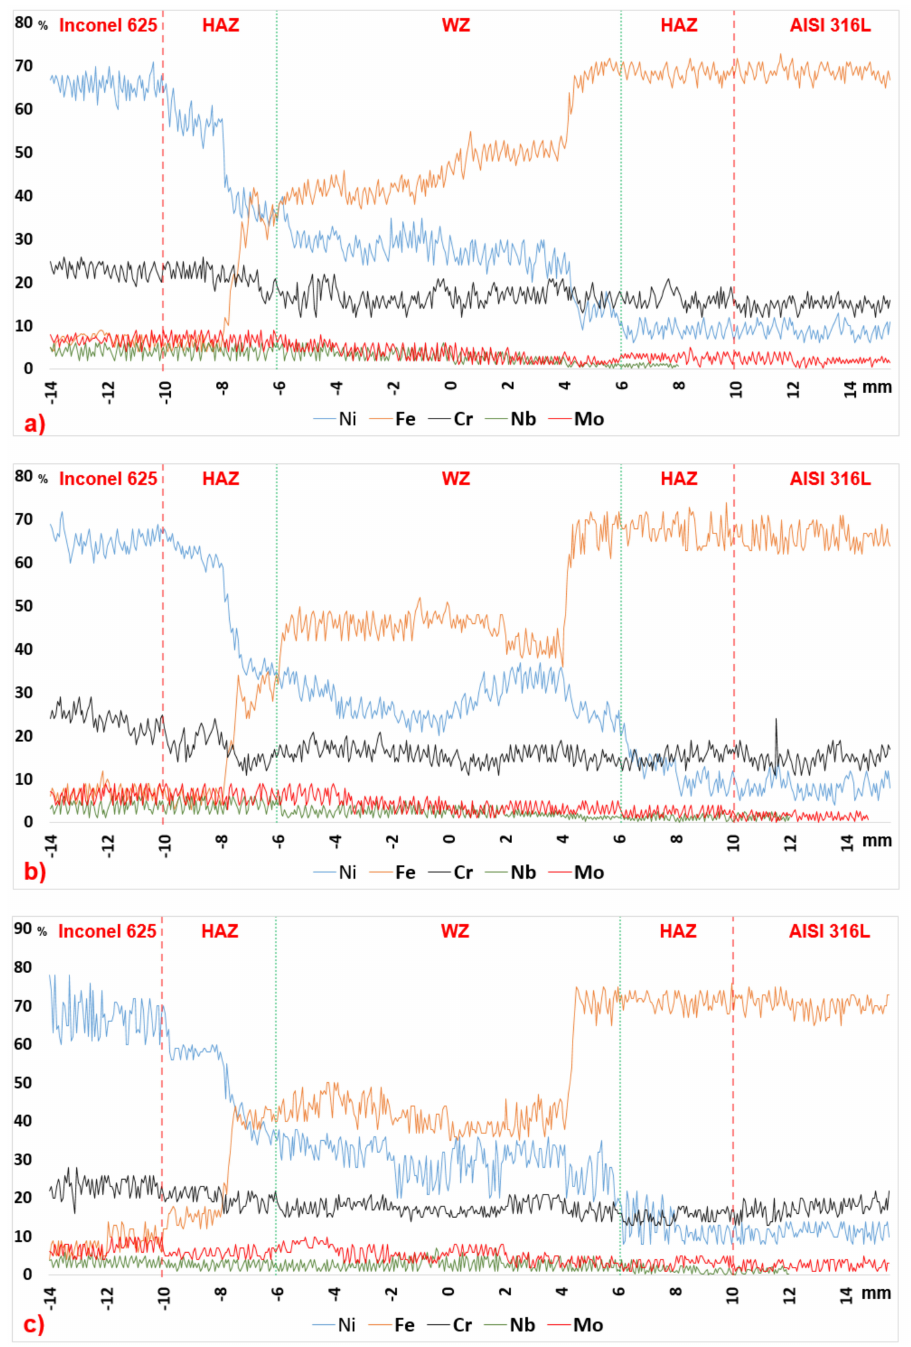
Figure 6. Line mapping analysis of bimetallic joints of Inconel 625 and AISI 316L obtained by CCGTA welding, employing ERNiCr3 ( a ), TIG 316L ( b ), Twisted Filler ( c